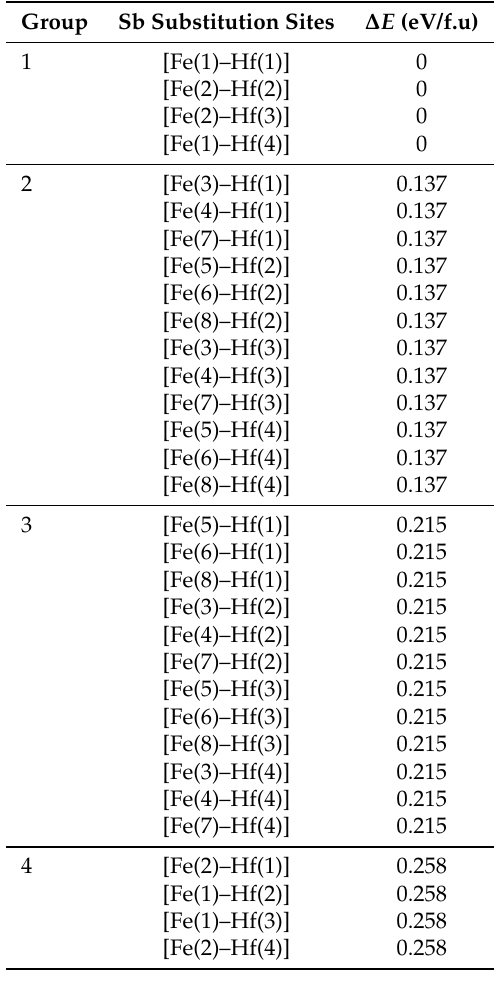
Table A1. The total energy difference ∆ E (eV/f.u.) relative to the lowest energy configuration for 32 ordered configurations of Fe 7 Hf 3 Sb 2